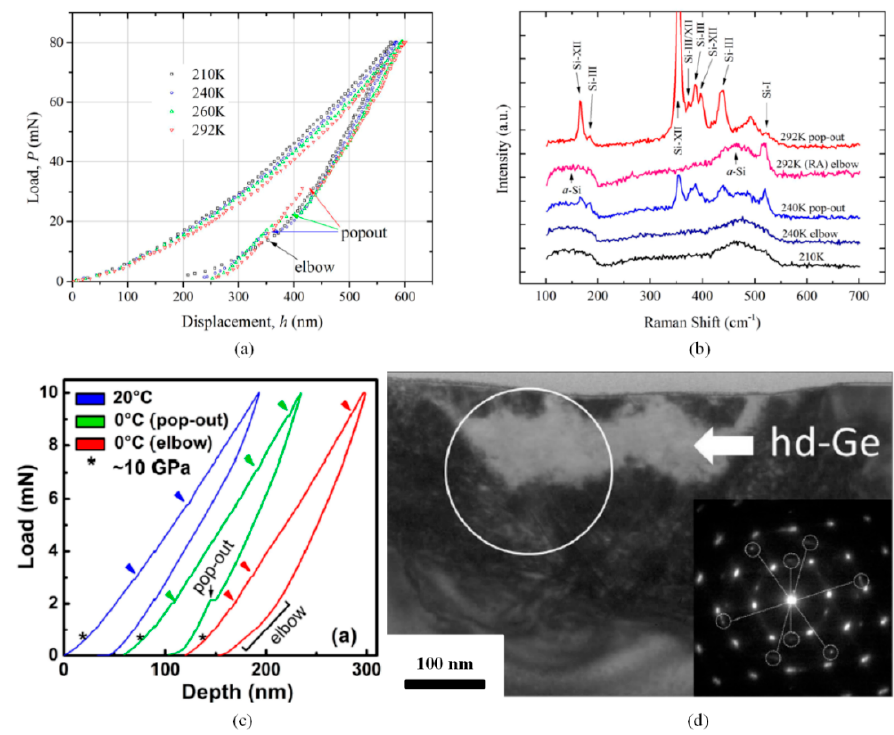
Figure 20. Low temperature indentation on monocrystalline semiconductors. ( a , b ) P - h curves and typical Raman spectra of indented silicon [74]. ( c , d ) P - h curves and TEM result of indented germanium with pop-out [75].